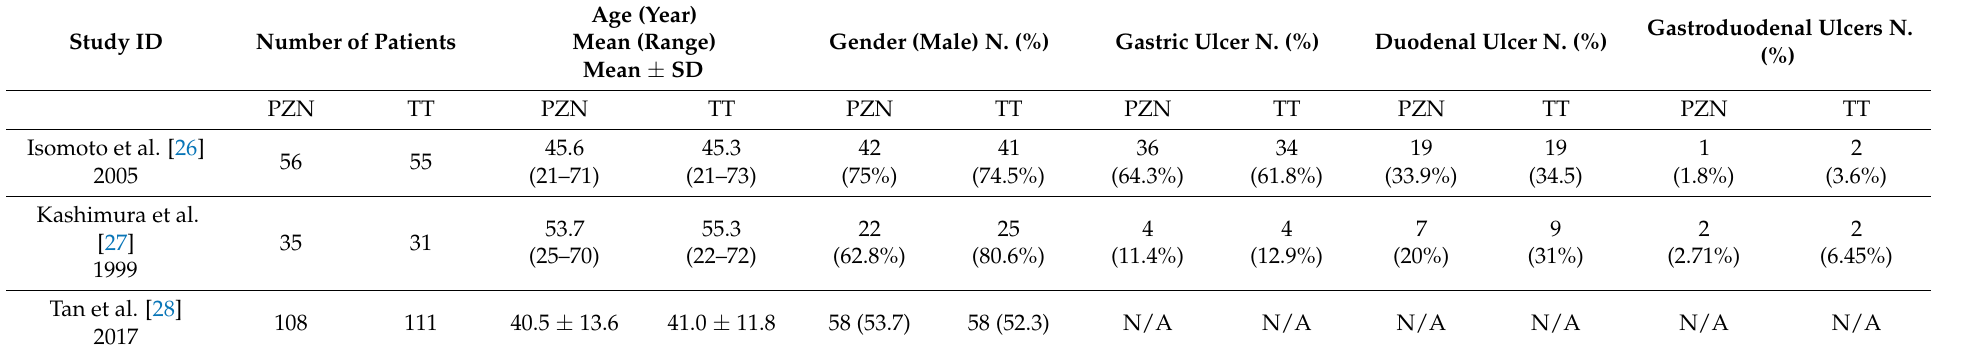
Table 3. Baseline characteristics of the